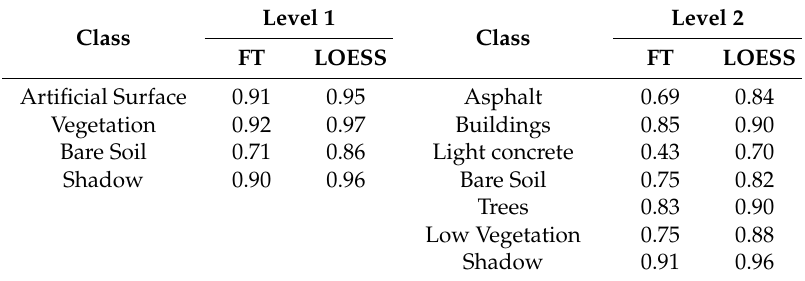
Table 6. F-score for each class for each classification level and segmentation method.